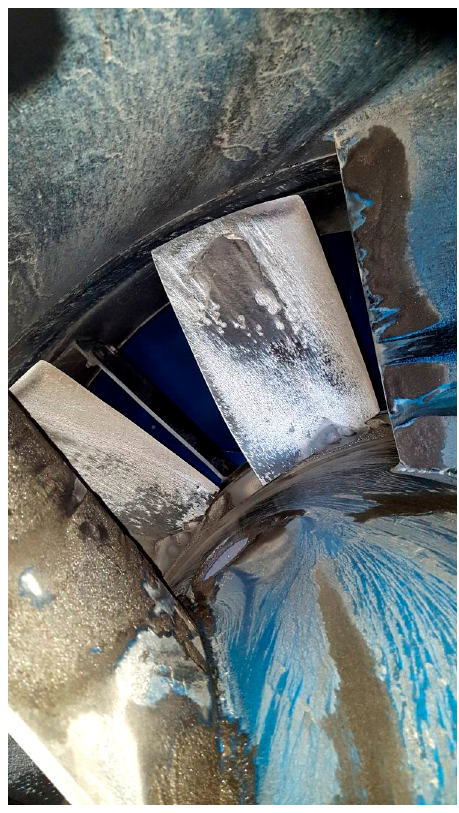
Figure 1. Mine fan subjected to erosive wear.